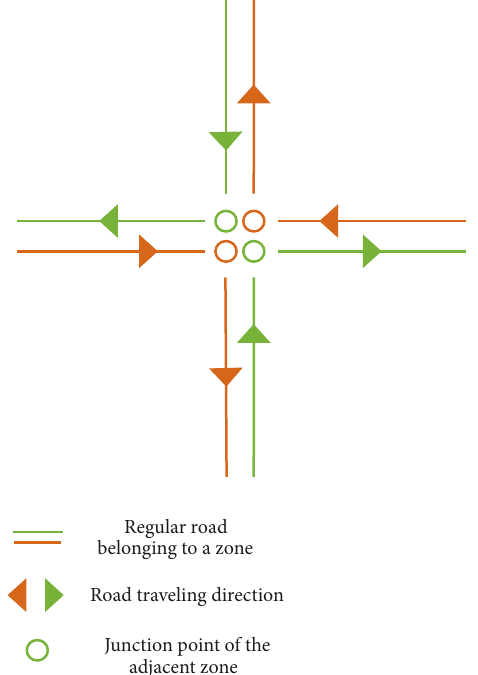
Figure 17: Details of an intersection of regular roads between 4